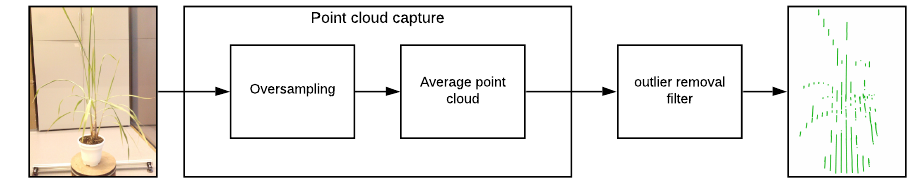
Figure 7. Point cloud oversampling and filtering diagram.